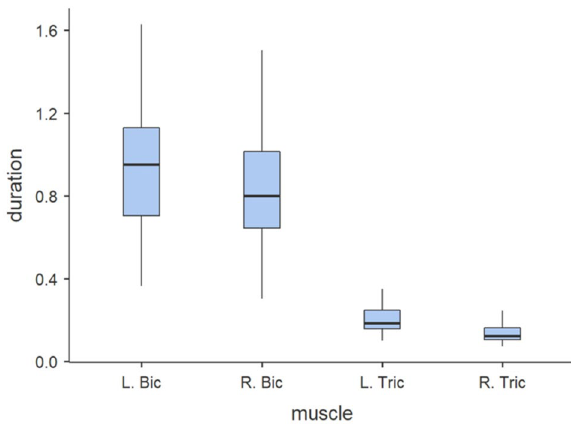
Figure 1. Duration of muscle activation time during the free-throw [s].